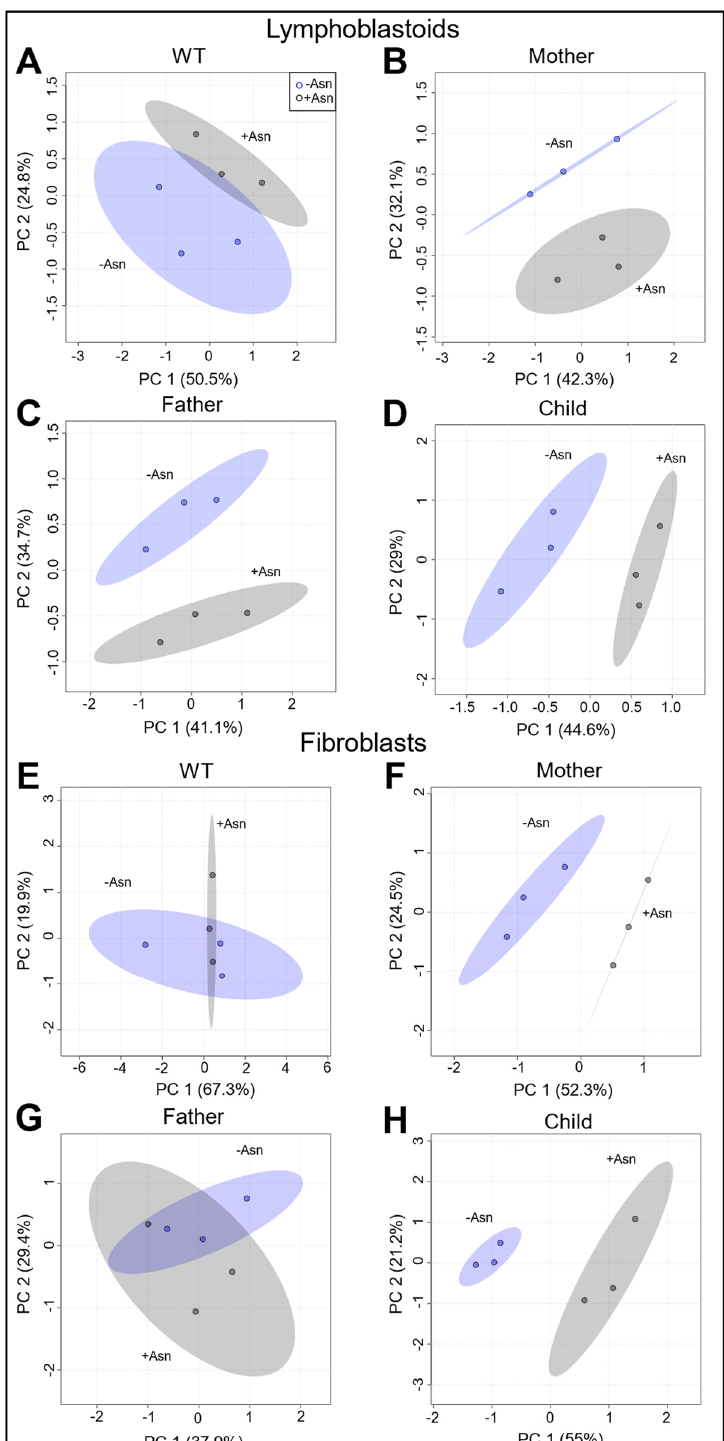
Figure 2. Principal component analysis of lymphoblastoids (LCL) and fibroblasts incubated with +Asn or − Asn media. All metabolites were normalized to DL-norleucine. Panels ( A – D ) represent 2D score plots for LCL and demonstrate evident separation between +Asn and − Asn conditions in maternal, paternal, and child cells with greater grouping between conditions in WT. 2D score plots for fibroblast cell lines demonstrate clear separation between conditions for maternal and child cells with greater evident grouping in WT and paternal cells (Panels E – H ). For each 2D score plot, the shading indicates the 95% confidence intervals of each